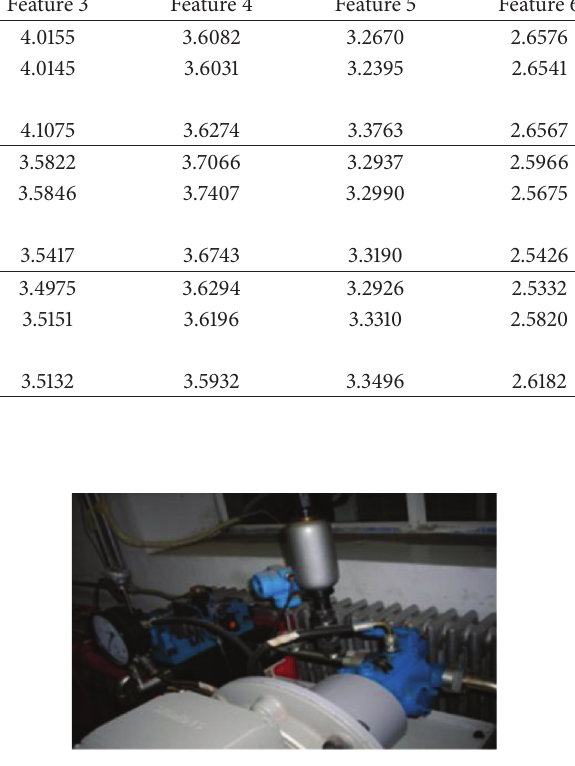
Figure 3: Plunger pump